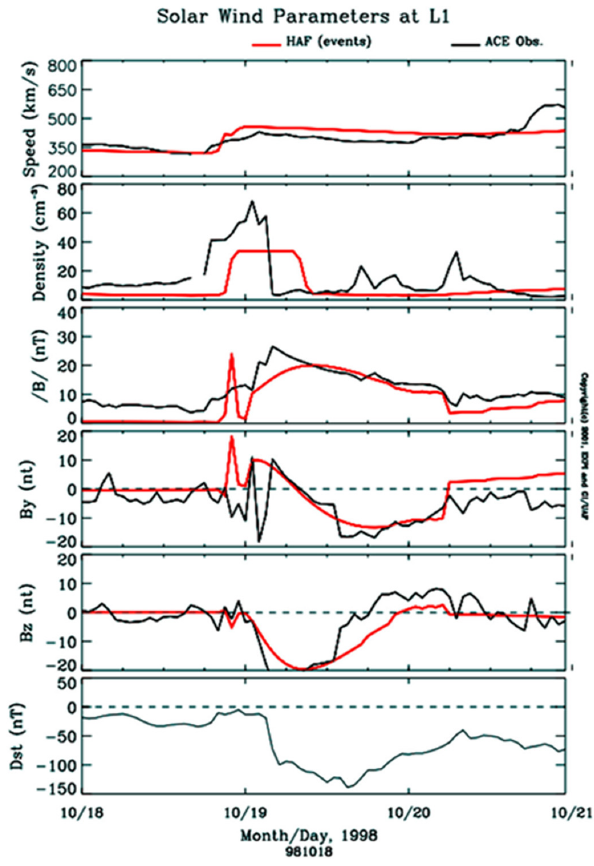
Fig. 23b. The observed magnetic field changes and the simulated changes based on the model shown in Fig. 23a (Saito et al.,